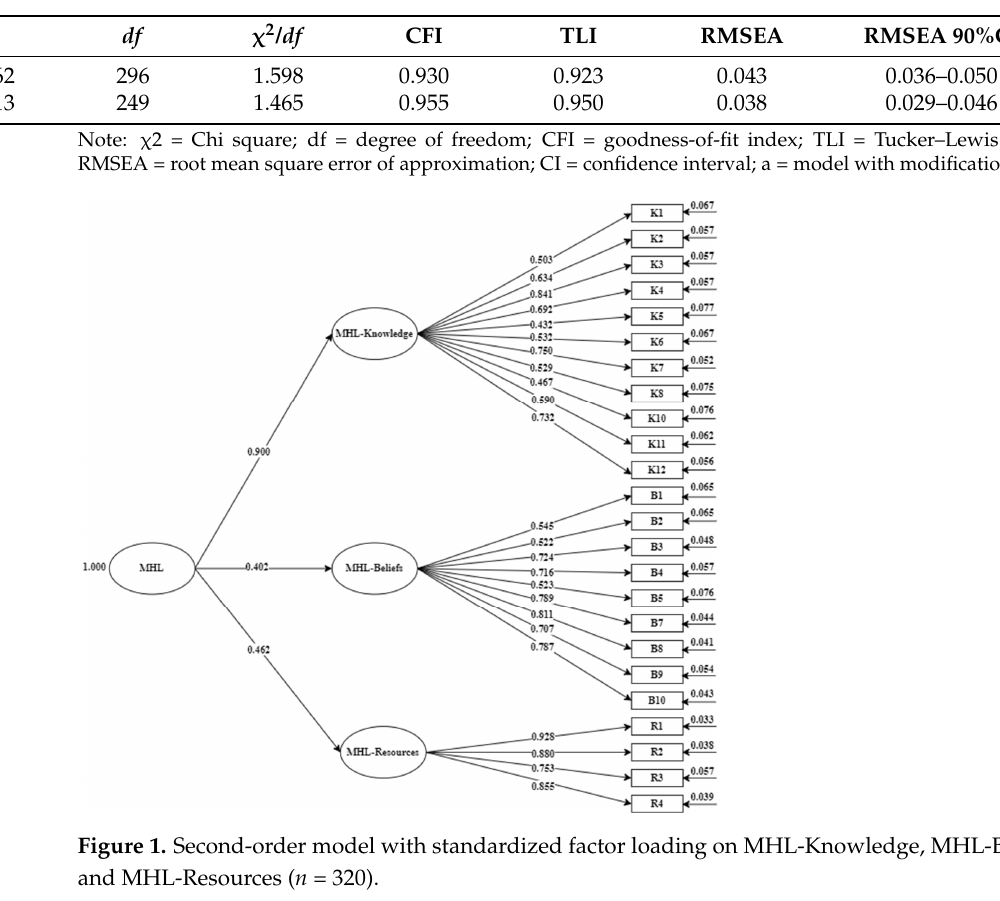
Table 1. Model fit indices of the second-order three-dimensional MMHLS in elite athletes ( n = 320).